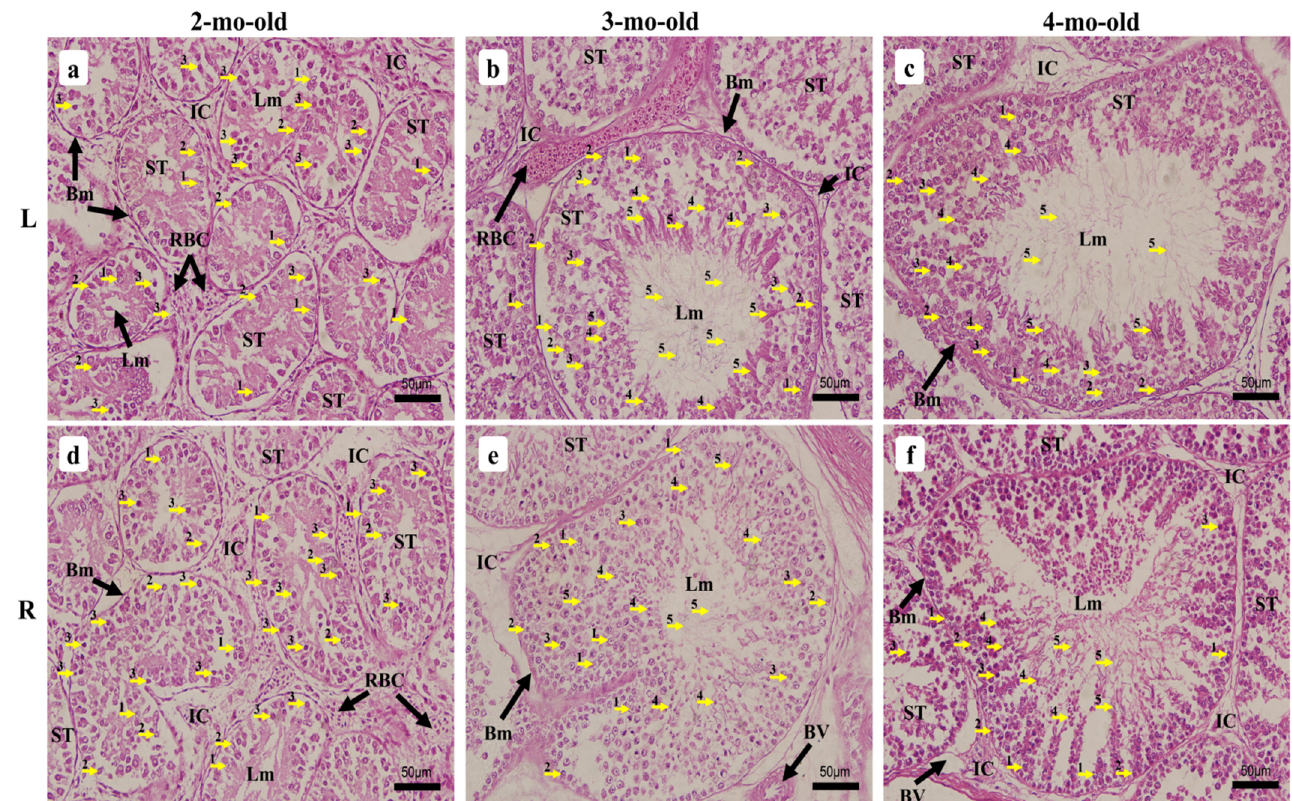
Figure 9. Histological micrographs of chicken testes during growth from 2-mo-old to 4-mo-old, 400× magnification. ( a , d ) 2-mo-old; ( b , e ) 3-mo-old; ( c , f ) 4-mo-old. Left testis (L), right testis (R), basement membrane (Bm), seminiferous tubules (ST), intertubular compartments (IC), avian red blood cells (RBC), lumen (Lm), blood vessels (BV), Sertoli cells (1), spermatogonia (2), spermatocytes (3), spermatids (4), spermatozoa (5).